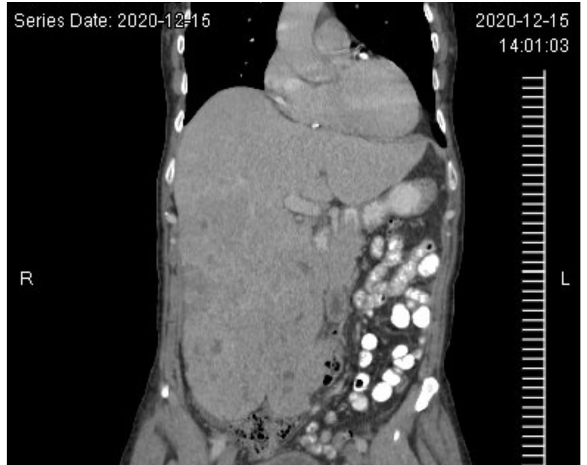
Figure 4: Abdominal CT image. CT image demonstrating massive tumor recurrence in the liver after surgical resection of primary tumor and prior to initiation of